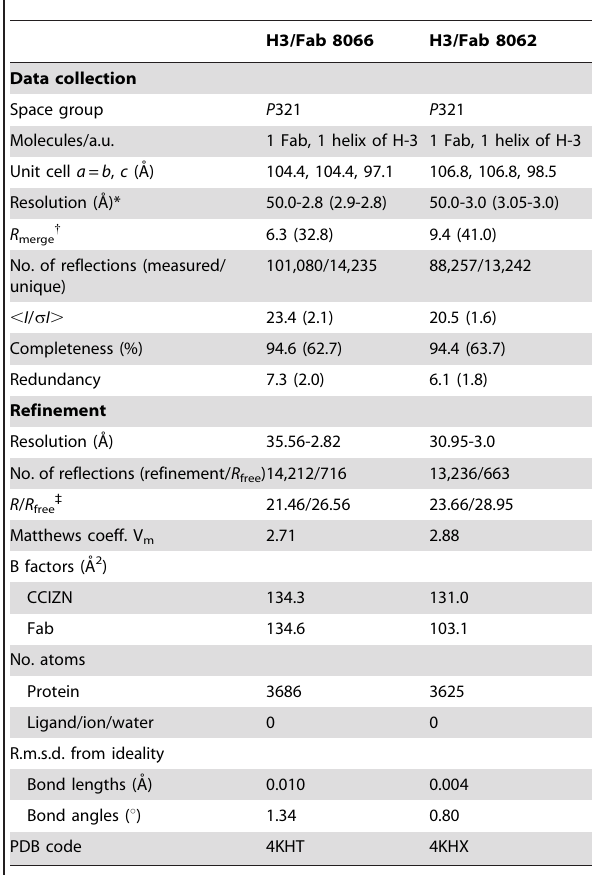
Table 1. Crystallographic data collection and